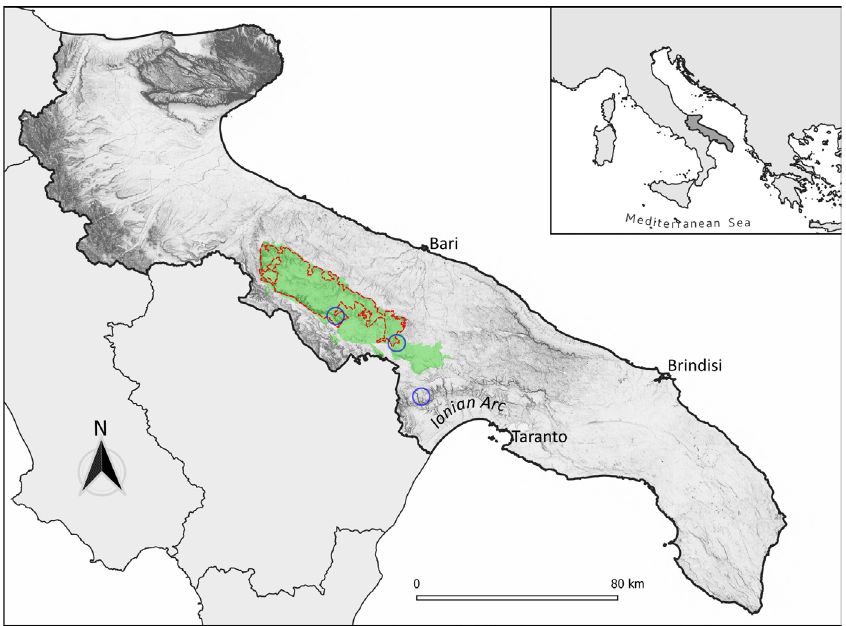
Figure 1. Study area. SCI/SPA “Murgia Alta” IT9120007 in green and “Alta Murgia” National Park with red boundaries. The blue circles indicate the location of the sample